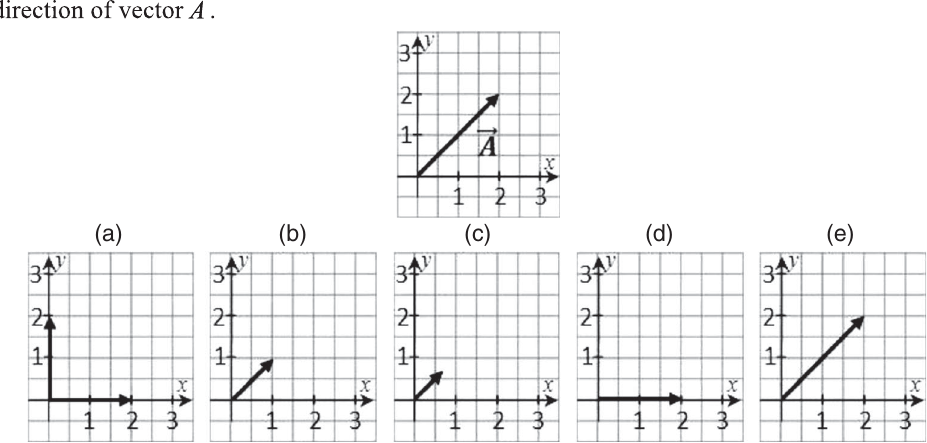
~A ˆ i ˆ j ¼ 2 þ 2